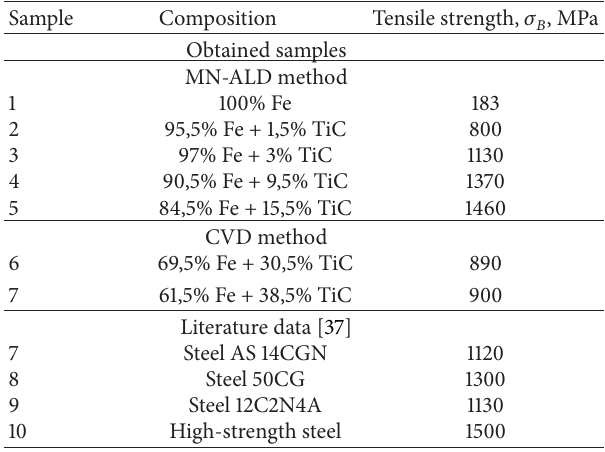
Table 4: The study of mechanical properties of the synthesized composite materials based on iron with dispersed phase of